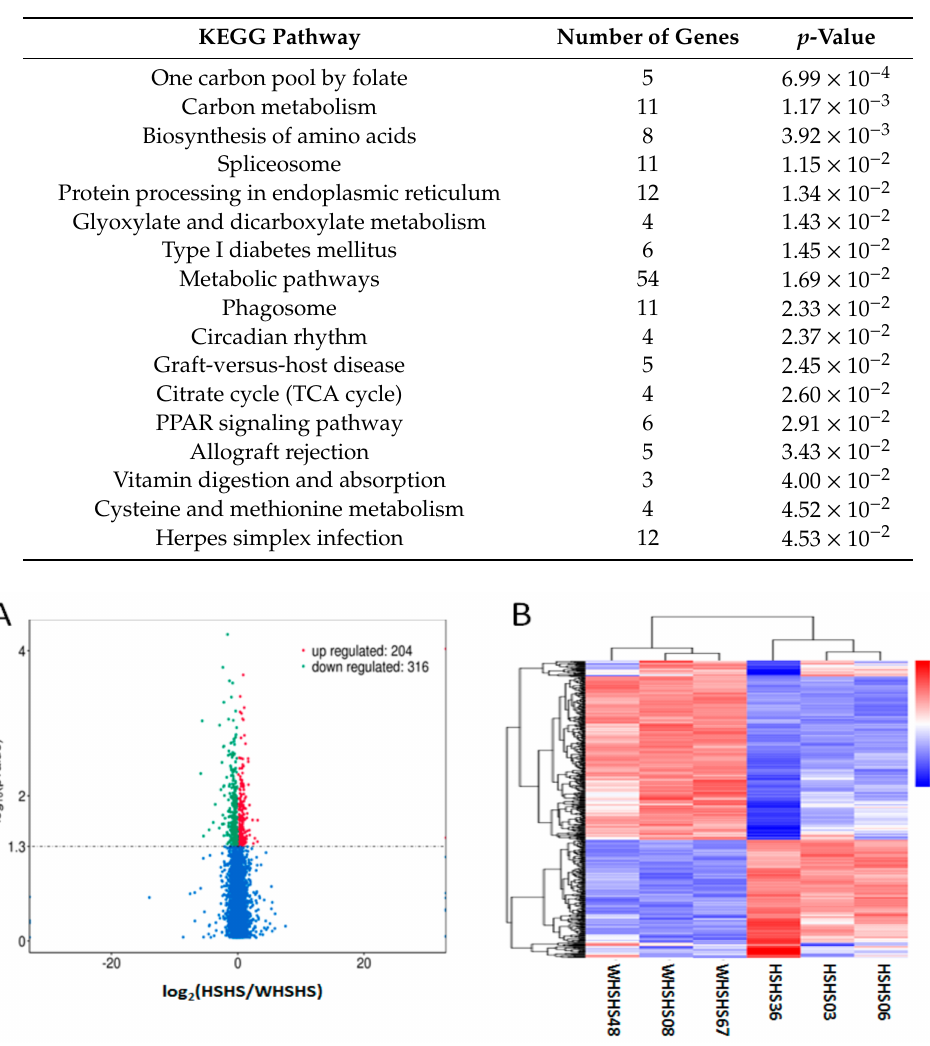
Figure 1. Analyses of di ff erentially expressed mRNAs in the RNA-seq libraries. ( A ) Volcano plot showing the overall distribution of the di ff erential transcript or gene, with the threshold set to q < 0.05. Red: the genes significantly upregulated in the heat stress group ( p < 0.05); Green: the genes significantly downregulated in the heat stress group ( p < 0.05). ( B ) Hierarchical clustering analysis of mRNA expression profiles with 520 di ff erentially expressed